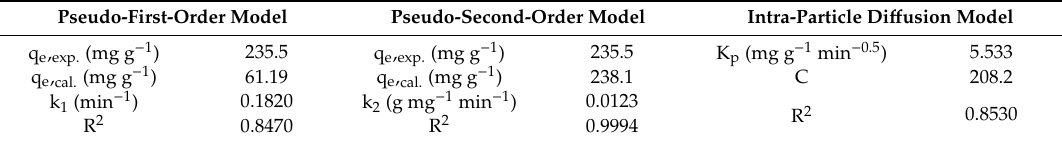
Table 2. Kinetic parameters of Pt(II) adsorption onto the TEBAC-HKUST-1 MOR.